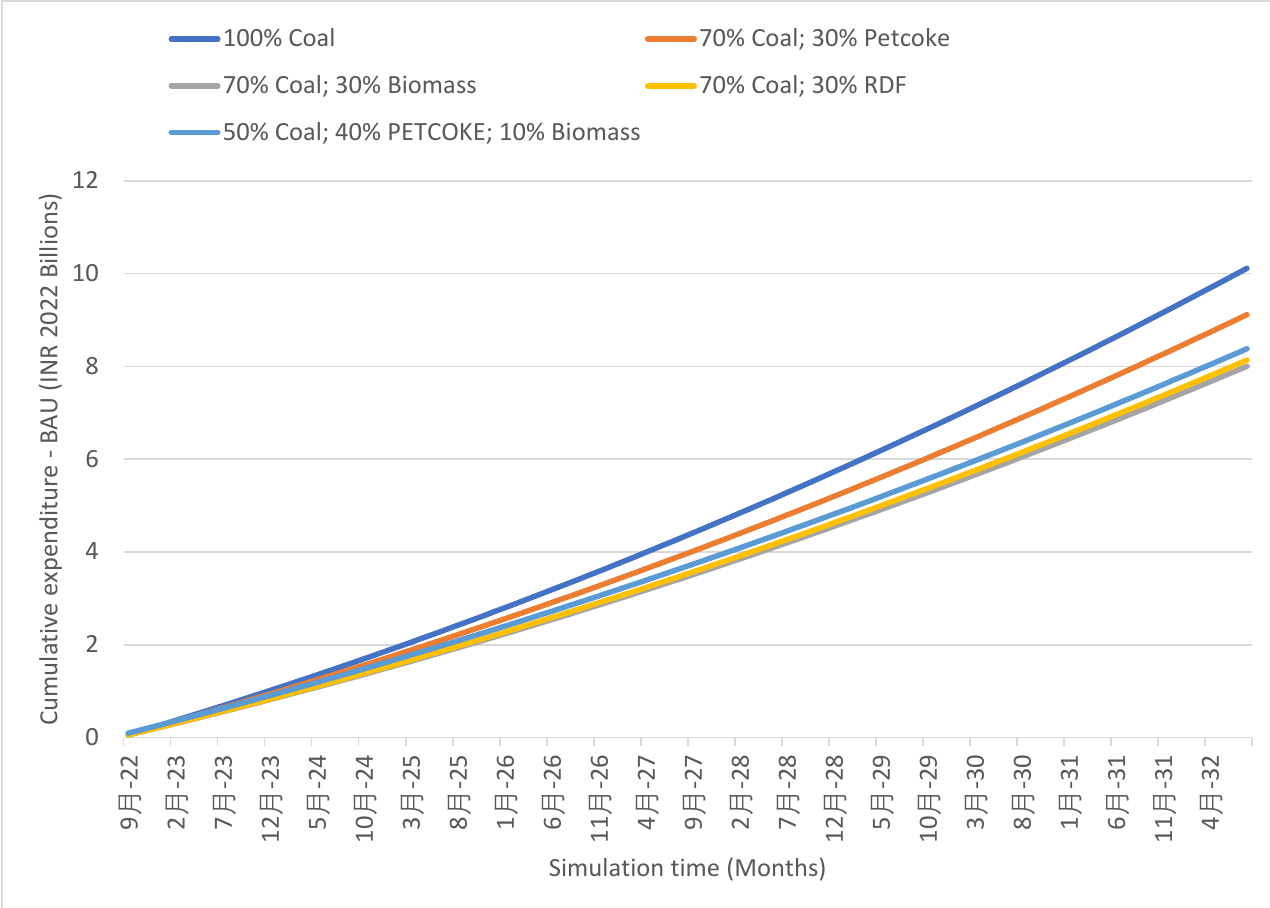
Figure 7. Cumulative expenditure under BAU scenario for various fuel-mix configurations.